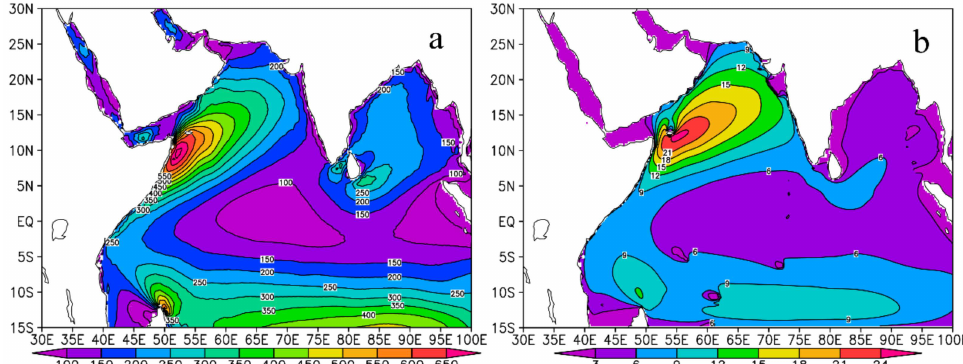
Figure 6. Characteristics of annual average wind energy density (unit: W / m 2 ) ( a ) and wave energy density (unit: KW / m) ( b